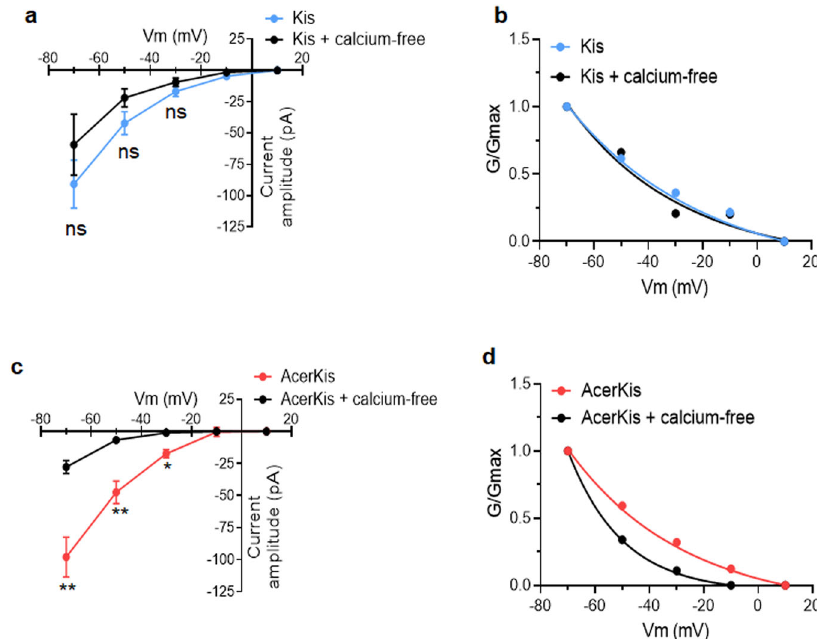
Fig. 5 Pretreatment with EGTA-buffered calcium-free solution reduces the ACh-induced current amplitude in AcerKis neurons but has no effect in Kis neurons. a , c The ACh-evoked inward current currents (pulse application of 1 mM ACh, 3 s in duration) were recorded for holding potentials ranging from − 70 to + 10 mV with 10 mV steps every 2 min in control and in the presence of EGTA-buffered calcium-free solution in Kis neurons ( a ) and in AcerKis neurons ( c ). The mean values of the peak current amplitude recorded in Kis neurons ( n = 6 – 9) and in AcerKis neurons ( n = 3 – 9) were plotted as a function of the holding potential. Bars represent mean ± S.E.M. The statistical test used was Student unpaired t -test, ** p < 0.01; * p < 0.05; ns, non-signi fi cant. The number of experiments ( n ) are biologically independent samples. It should be noted that the ACh-induced current amplitude recorded in AcerKis neurons is signi fi cantly reduced in the presence of EGTA-buffered calcium-free solution. b , d Normalized chord conductances of ACh-induced current (G/Gmax) are plotted versus membrane potential in control and in the presence of EGTA-buffered calcium-free solution in Kis ( b ) and AcerKis ( d ) neurons. Changes in the current amplitude and the associated reduction in the maximal calculated conductance indicate that nAChRs activated by ACh (1 mM) are at least permeable to calcium in AcerKis